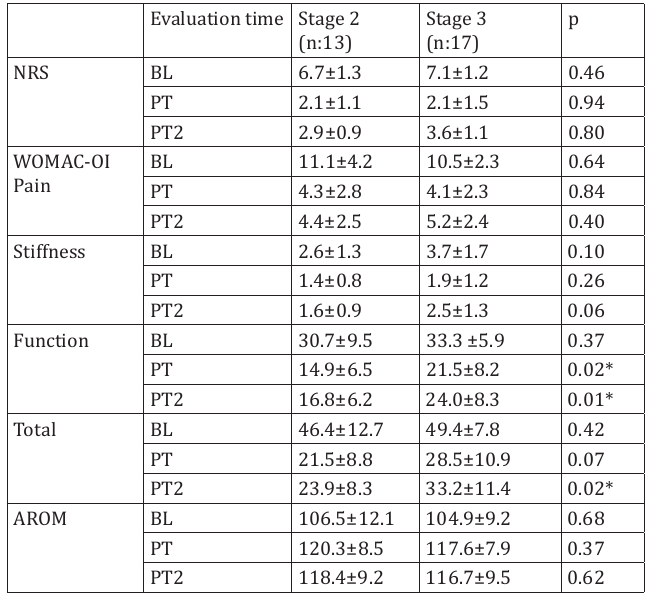
Comparison of NRS, AROM, and WOMAC-OI of K-L Stage 2 and Stage 3 OA patients